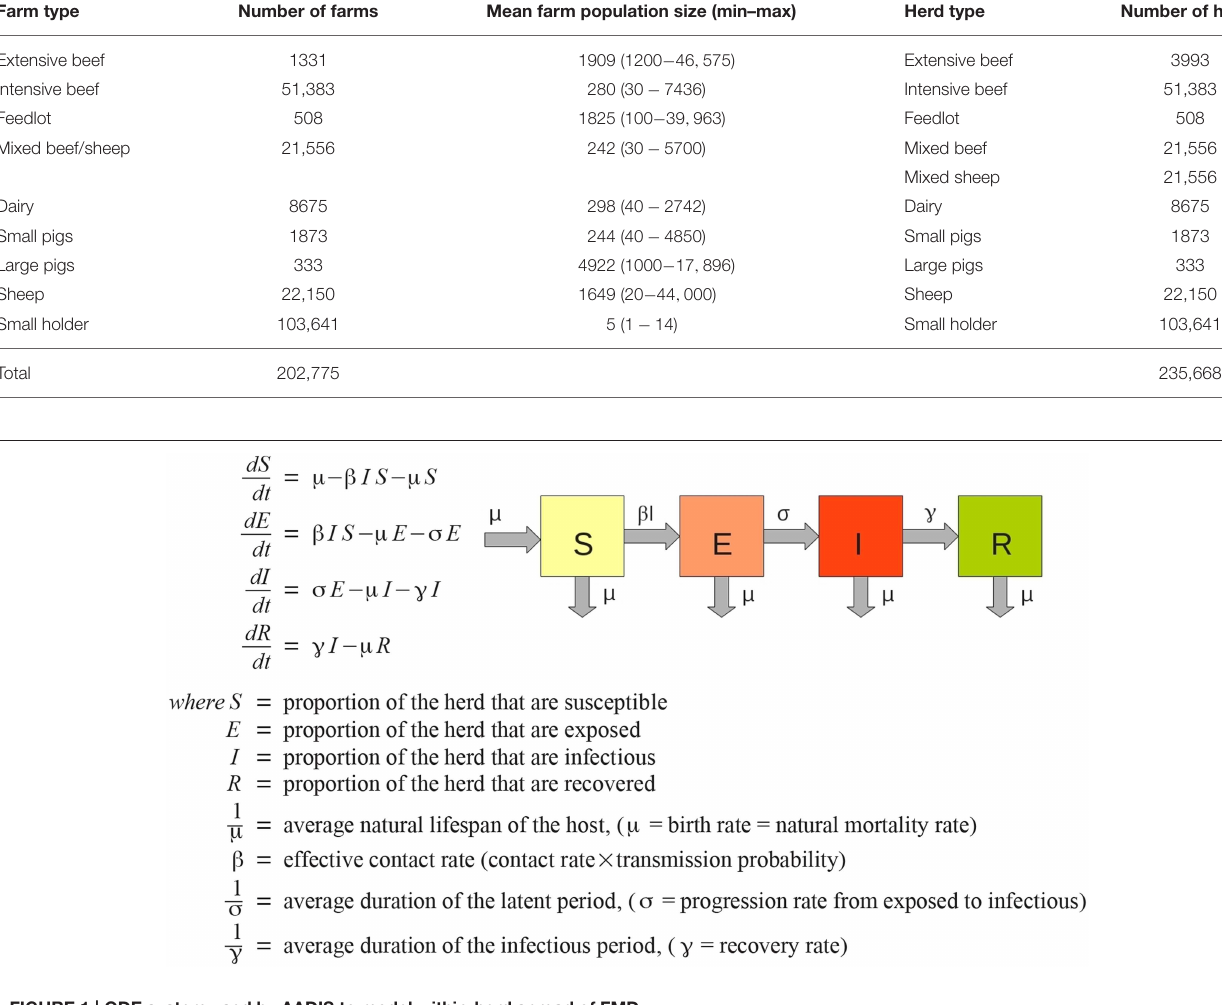
FIGURE 1 | ODE system used by AADIS to model within-herd spread of